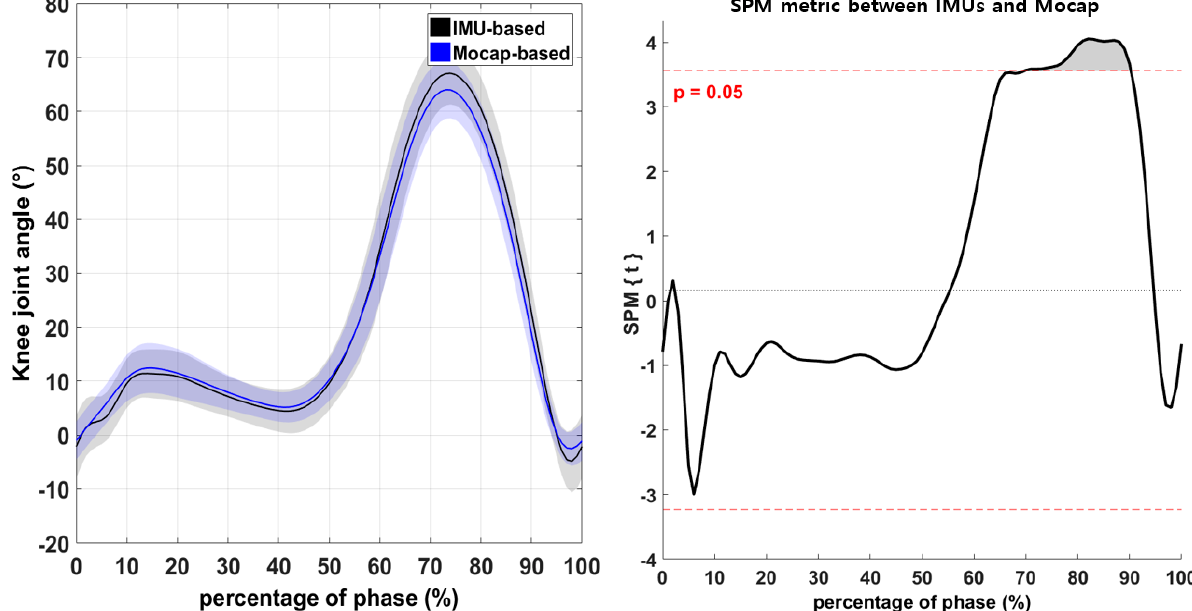
Figure 4. Comparison of the knee-joint angle between the IMU-based and Mocap systems according to one-dimensional SPM. Horizontal dashed lines illustrate significant differences at α = 0.05, and the result is visualized as a waveform (the gray area in the figure on the right indicates significant differences).